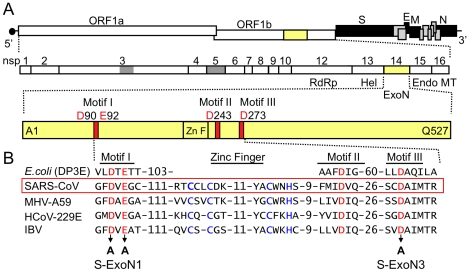
SARS-CoV genome organization and nsp14 exoribonuclease motifs.(A) SARS-CoV genome organization and ORF 1a/b polyprotein expression. The genome is a 29.7-kb positive-sense RNA molecule that is capped (dark circle) and polyadenylated. Genes are indicated for the replicase (ORF 1a and ORF 1b; white), structural proteins [Spike (S), Envelope (E), membrane (M), and nucleocapsid (N) proteins; black], and accessory proteins (light gray). ORF 1b is accessed by ribosomal frameshift in the nsp12 coding sequence. The ORF 1a/b polyprotein is translated directly from input genome RNA and processed into 16 mature nsps by two virus-encoded proteinases (gray). Nsps have predicted or demonstrated activities as described in the text. Hel, helicase; Endo; endoribonuclease; MT, 2′-O-methyltransferase. (B) Organization of nsp14 and partial sequence alignment of representative CoV nsp14 sequences with Eschericia coli DNA polymerase III epsilon subunit (DP3E), the proofreading exonuclease subunit of the replicative DNA polymerase (SwissProt P03007). Sequence alignment and GenBank accession numbers for the full-length CoV genomes are as in [20]. Active-site residues of conserved motifs I to III of the DEDD superfamily are indicated in red and by amino acid position in nsp14. A predicted zinc finger domain (Zn F) is located between motifs I and III in the viral sequences, and the predicted zinc-coordinating residues are shown in blue type. Residues replaced with alanine are indicated by black arrows for SARS-CoV mutants S-ExoN1 and S-ExoN3.